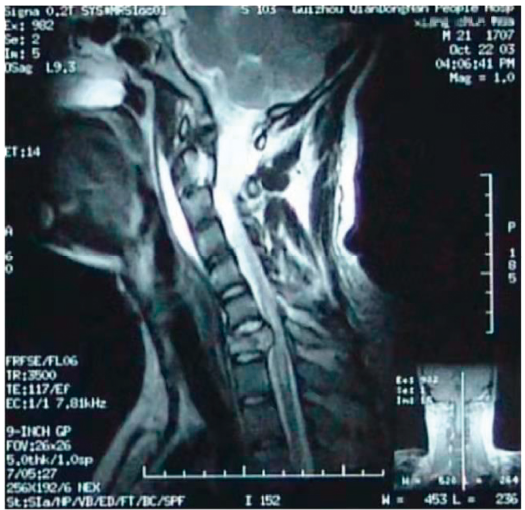
Figure 1: The spinal cord was compressed by fracture vertebral body. Figure 2: The cavitation volume is about 1 × 0.5 × 0.5cm 3 in cervical vertebral